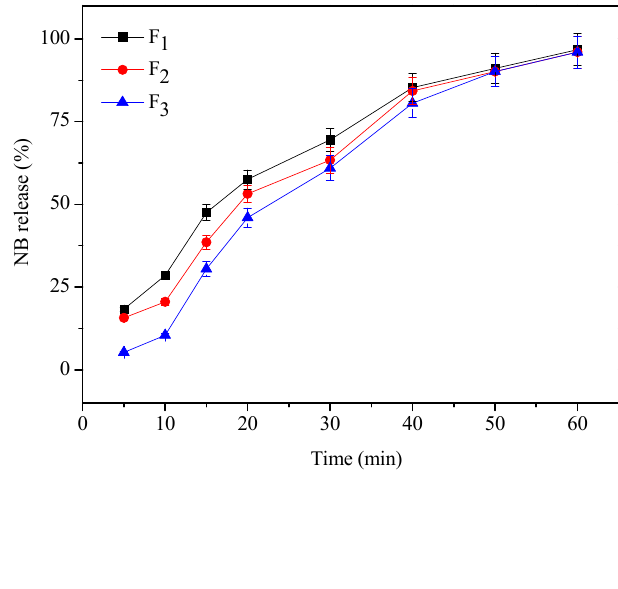
Figure 3. The effect of NB/HP- β -CD on the release profile of NB fromthermosensitive composite hydrogel ( n = 3) (F : Thermosensitive composite hydrogel adding 1% NB/HP- β - 1 CD; F : Thermosensitive composite hydrogel adding 2% NB/HP- β -CD; F 2 composite hydrogel adding 3% NB/HP- β